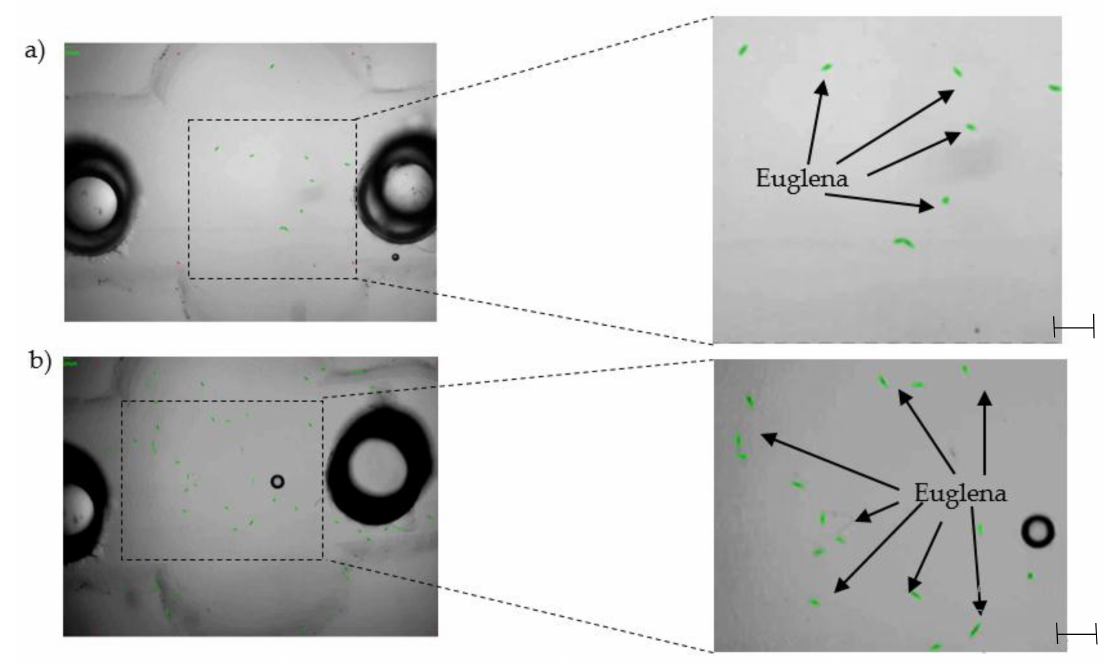
Figure 8. Growth of Euglena gracilis population on-chip ranging from 8 to 44 cells. E. gracilis colonies are marked as green dots by the software: ( a ) start of the test; ( b ) end of the test. Scale bar: 50 µ m.